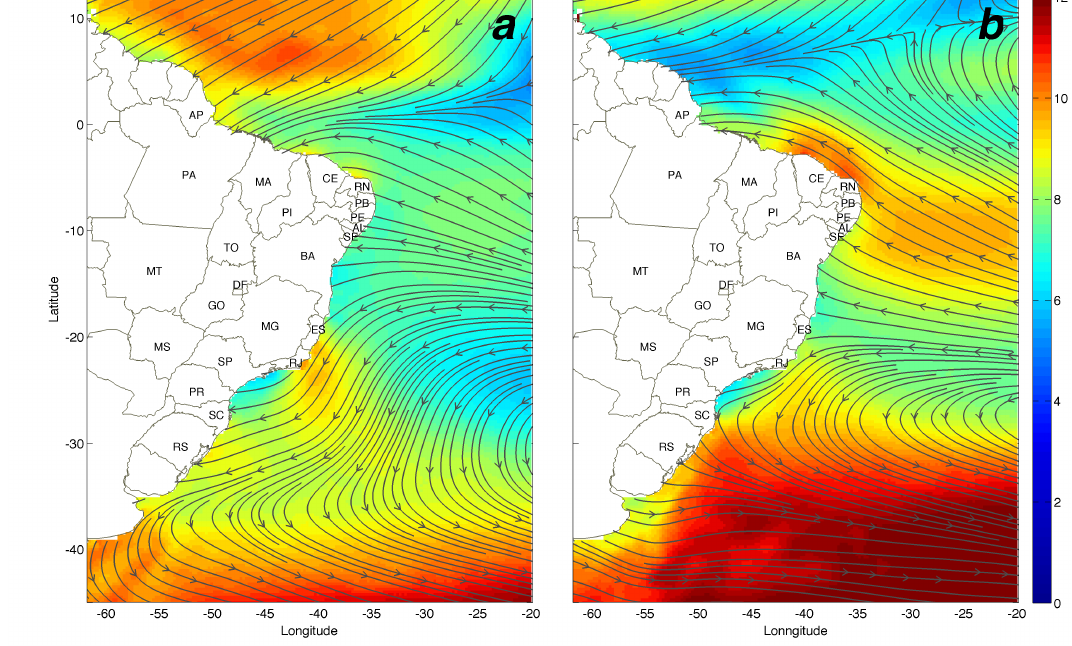
Figure 5. Climatological (1987–2014) wind speeds and streamlines for ( a ) January and ( b ) July. Colors indicate wind speed at hub height. Winds were extrapolated to z=95 m using the Monin–Obukhov stability-based method. States’ names are indicated in Figure